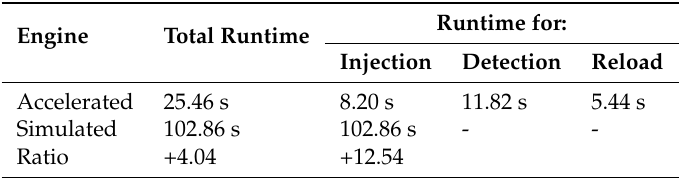
Table 9. Run time average of each acceleration step for the EX case.